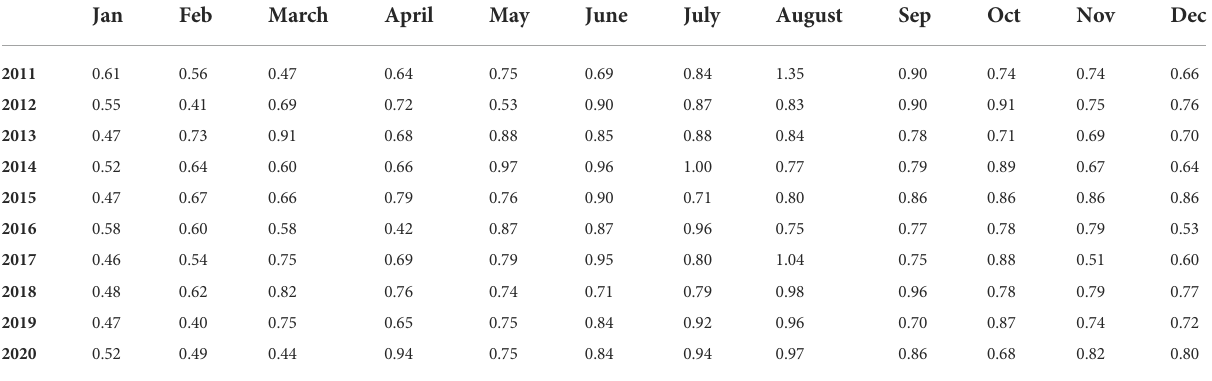
TABLE 3 Monthly averaged values of Signi fi cant wave height in east coast of Agatti island.